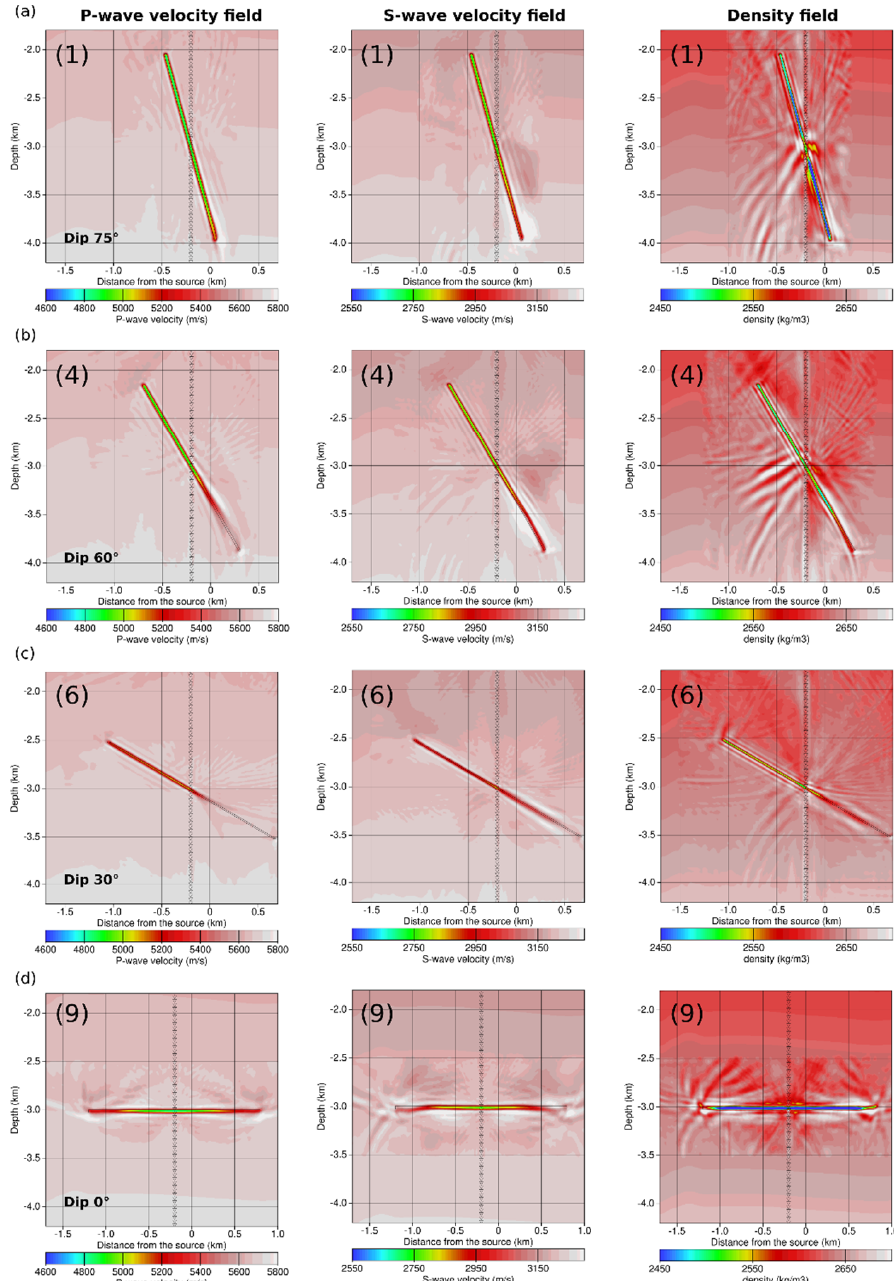
Figure 8. Sensitivity analysis results obtained for dip faults crossing the well at 3000 km depth. We show P-wave velocity (left), S-wave velocity (center) and density (right) fields for fault dips of ( a ) 75°, ( b ) 60°, ( c ) 30° and ( d ) 0°. These results correspond to faults 1, 4, 6 and 9 showed in Figure 7. We show only the interest area showed by the white rectangle in Figure 2c.